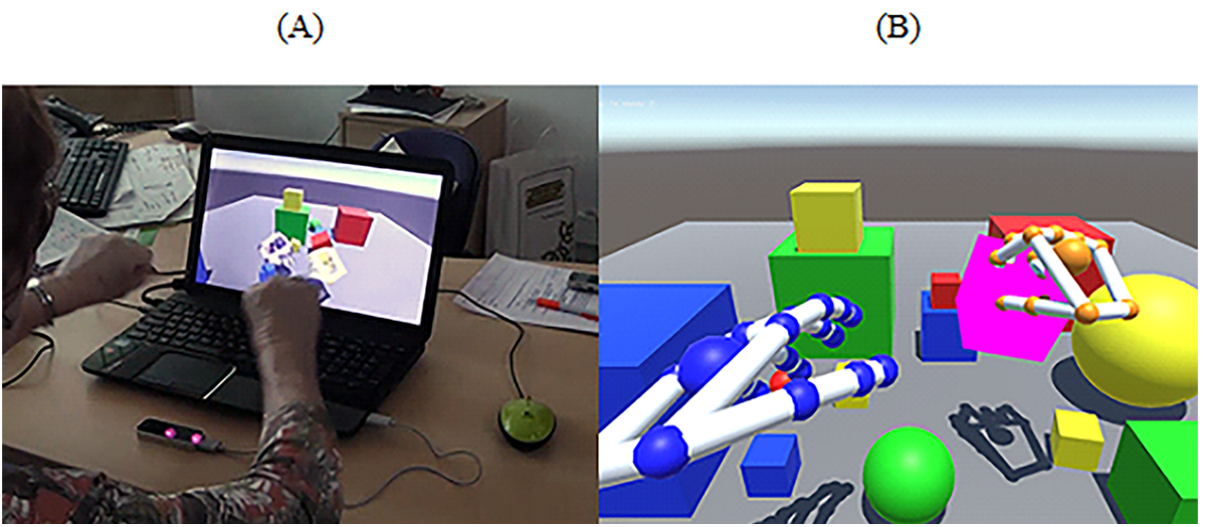
Figure 2. Virtual Playground. (A) Manipulating virtual objects tasks with hands through leap motion. (B) Print screen of the game. Participants had to interact freely with virtual objects.